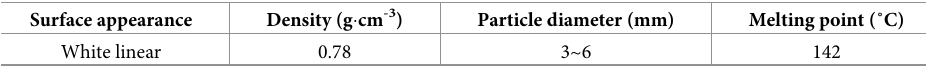
Table 4. The physical properties of asphalt modifier